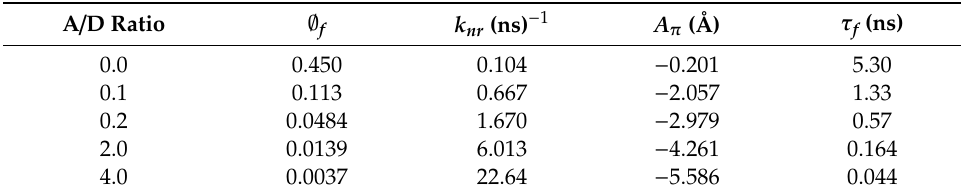
Table 1. Optical Properties of the Donor / Acceptor Thin